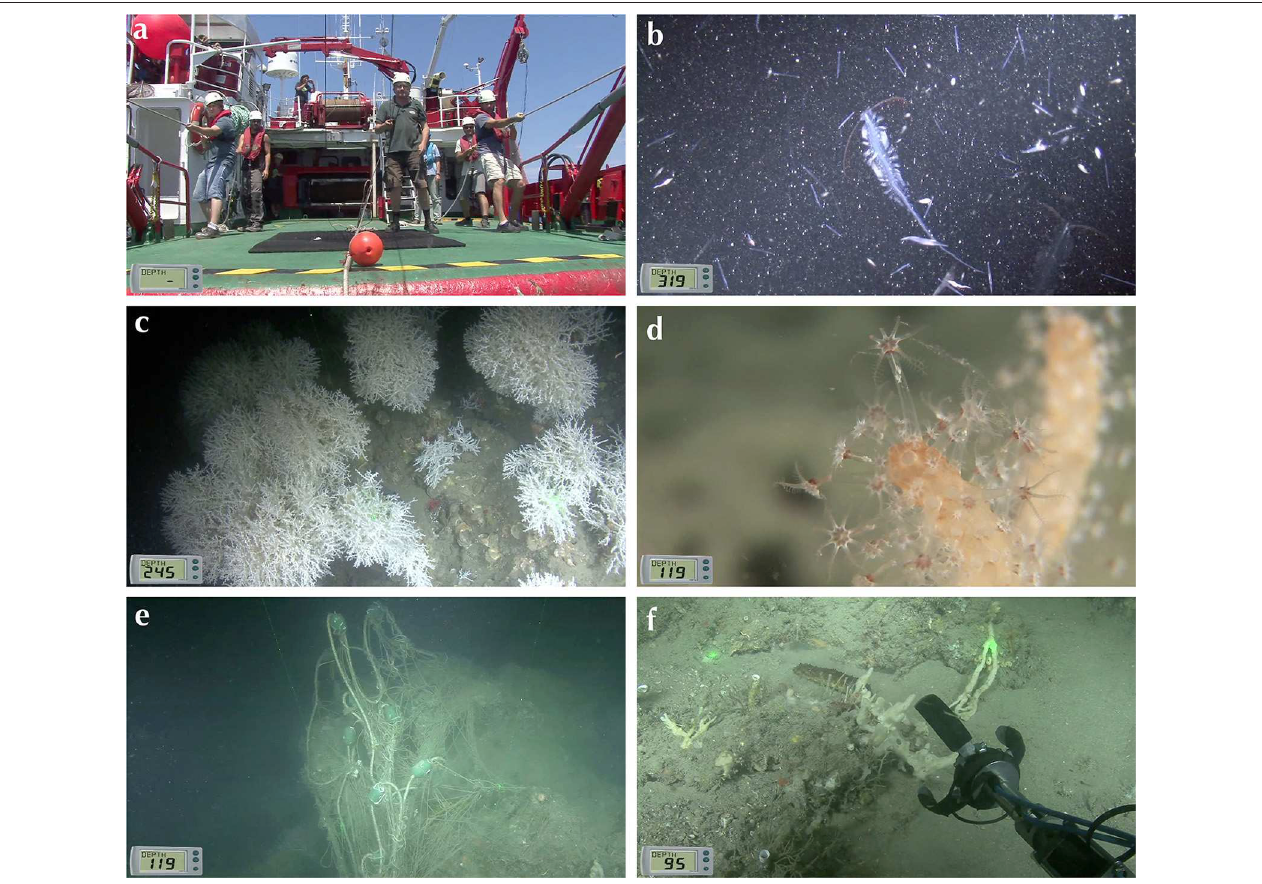
FIGURE 3 | Snapshots showing different moments of the virtual dive: (a) The deck of the R/V Garcia del Cid and its crew preparing themselves for the deployment. (b) At the deepest point, different plankton lifeforms can be observed in the water column. (c) Large colonies of the cold-water coral Madrepora oculat a beyond 200m depth. (d) A close-up image showing the polyps of the soft coral Alcyonium palmatum fully extended. (e) An abandoned trammel net caught on a rock on the continental shelf. (f) The moment when the submarine stops to collect a reptant sponge using the robotic arm installed on the